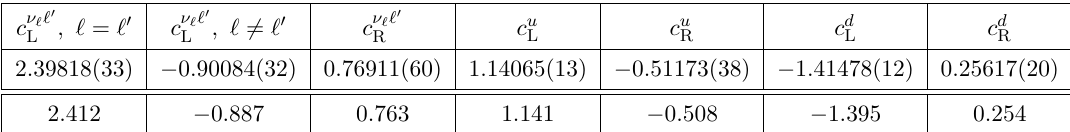
Table 1 . Top row: effective couplings (in units 10 − 5 GeV − 2 ) in the Fermi theory of neutrino- fermion scattering with four quark flavors within the MS renormalization scheme at the scale µ = 2 GeV . The error due to the uncertainty of Standard Model parameters is added in quadrature to a perturbative error of matching. For illustration, we have included the tree-level couplings. Coefficients are determined at the scale µ = M via a matching calculation and then run down Z to µ = 2 GeV via a renormalization group analysis. For a more detailed discussion see [120]. Bottom row: tree-level expressions for the same quantities are quoted to three decimal places. Notice that some Wilson coefficients receive O(1%) corrections. Tree level expressions are